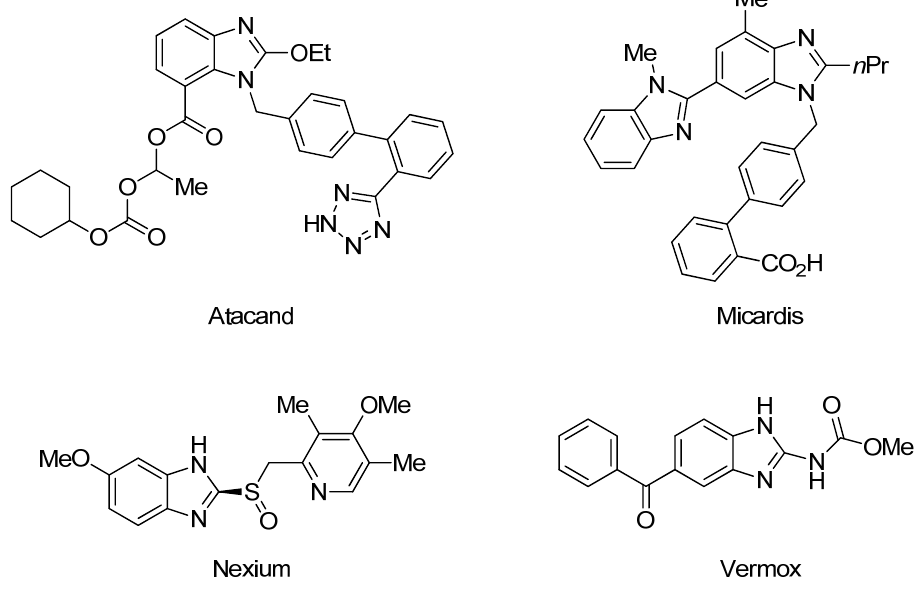
Figure 1. Structures of some pharmacologically important